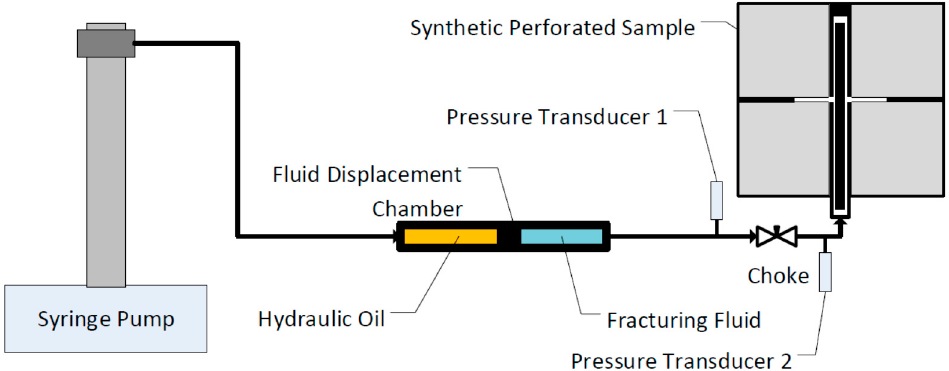
Figure 4. A schematic of fracturing fluid injection set-up.